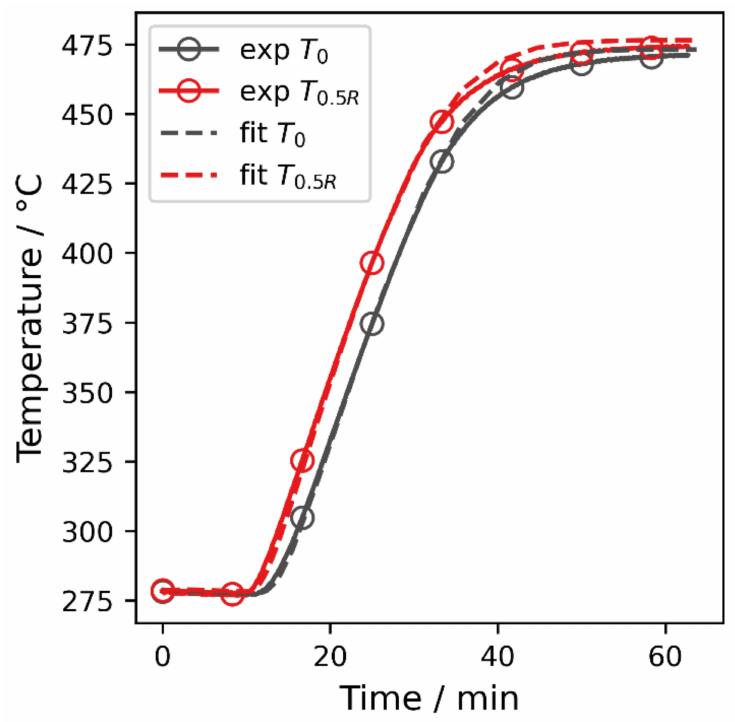
Figure 3. Comparison of measurements and simulation for the heating up procedure of Ca(OH) 2 without reaction at a steam pressure of 90 kPa. MAEs are 2.4 K for T 0 and 2.6 K for T 0.5R